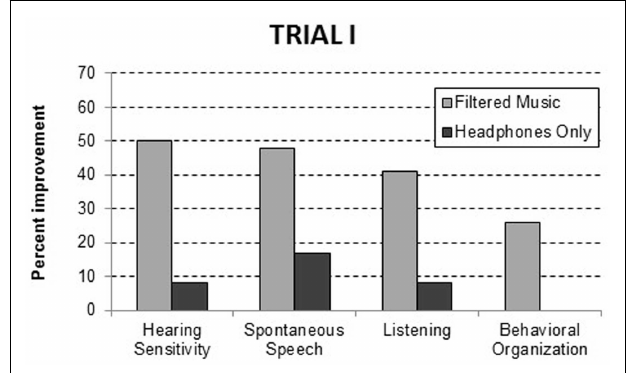
FIGURE 1 | Behavioral improvements at the 1-week post treatment assessment inTrial I .The data are reported as the precent of participants with a specific behavioral problem who improved.